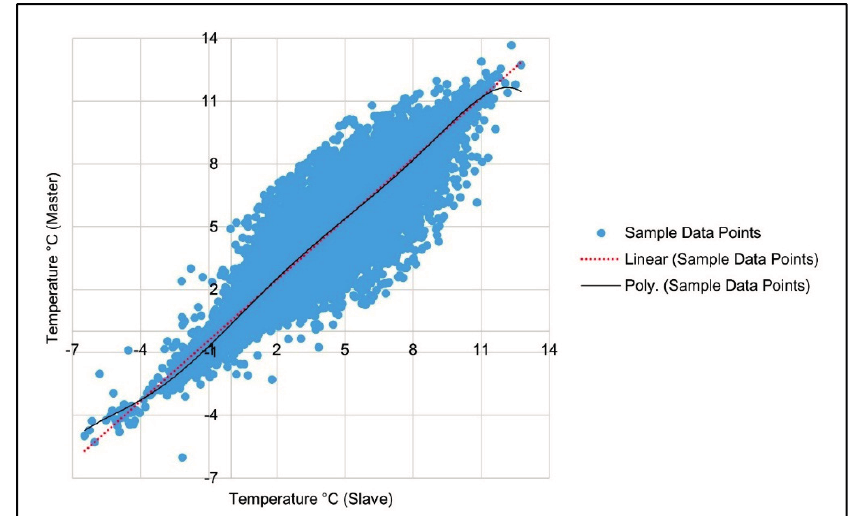
Figure 4. A scatterplot of no-change stratified random samples (NCSRS) with a sixth order polynomial trend line (black) and a linear trend line (red dotted) between the master and the slave